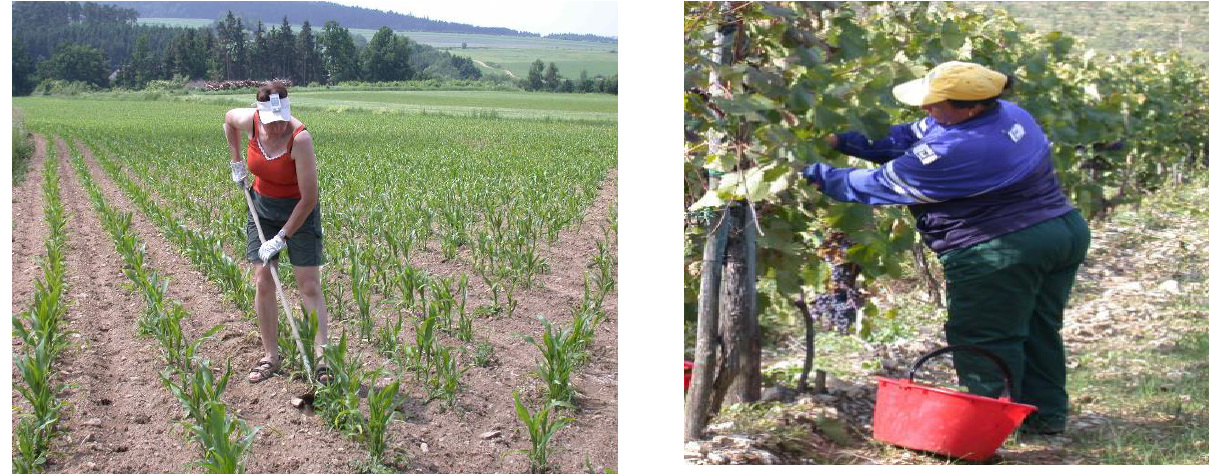
Figure 9. Exposure ratio to ambient UV radiation (ERTA) exceeding a value of 100% due to monotonic workflow. Left: Austrian farmer (organic farming, mixed-culture) during weeding, wearing an electronic personal solar UVR exposure (PE) meter mounted on the forehead [27]. Right: Italian vineyard worker during harvest equipped with two PSF badges (one on the back one on the arm) [153].